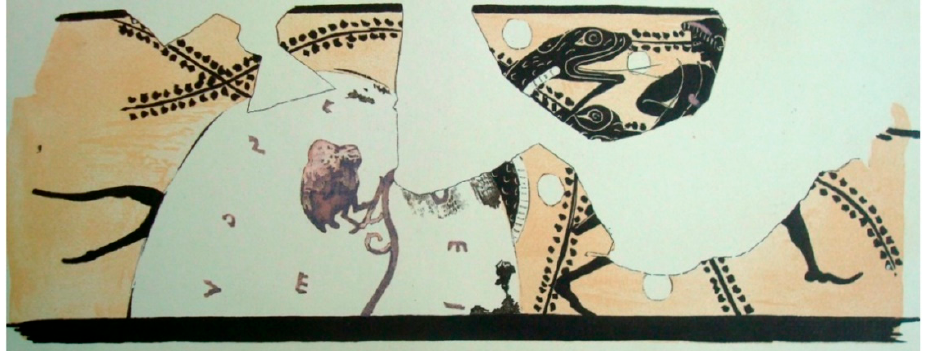
Figure 10. Two Bearded Snakes Pursuing Youth; black-figure lekythos; attr. to the Cactus Painter; Athens; ca. 500 BCE . [Image after (Brückner 1891, pl. 4)].